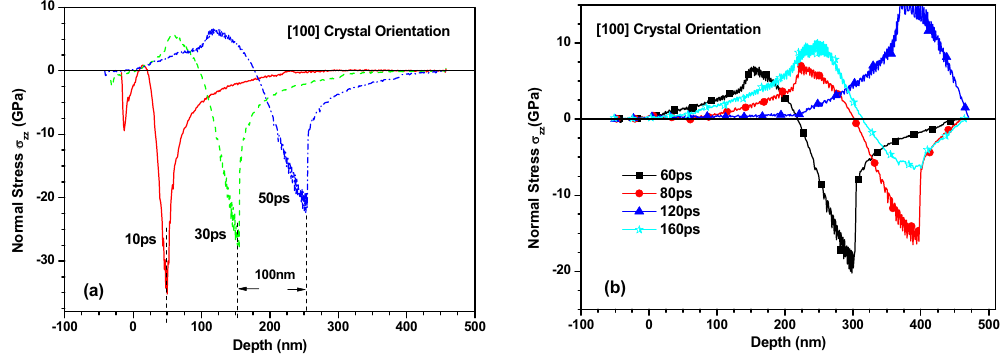
Figure 4. Normal stress ( σ zz ) distribution of 450 nm 〈 100 〉 copper films under an absorbed laser intensity of 0.065 J/cm 2 at 10–160ps time instant.